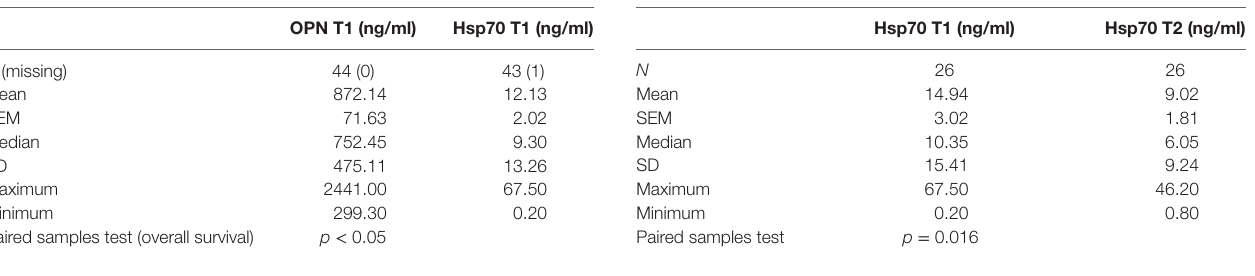
Table 3 | Comparison of pre-therapeutic (T1) osteopontin (OPN) and heat shock protein 70 (Hsp70) plasma levels in non-small-cell lung cancer patients (M0; n = 44) in relation to overall survival.